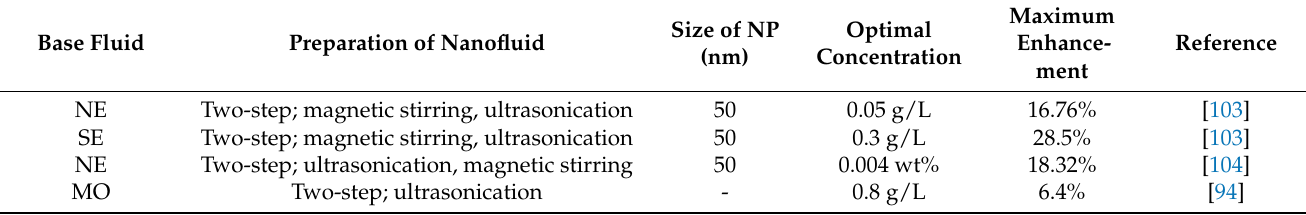
Table 4. Al 2 O 3 LI-BDV overview table. The size of NP refers to the nanoparticle core size, while the optimal concentration indicates the concentration value for which the maximal enhancement of LI-BDV was